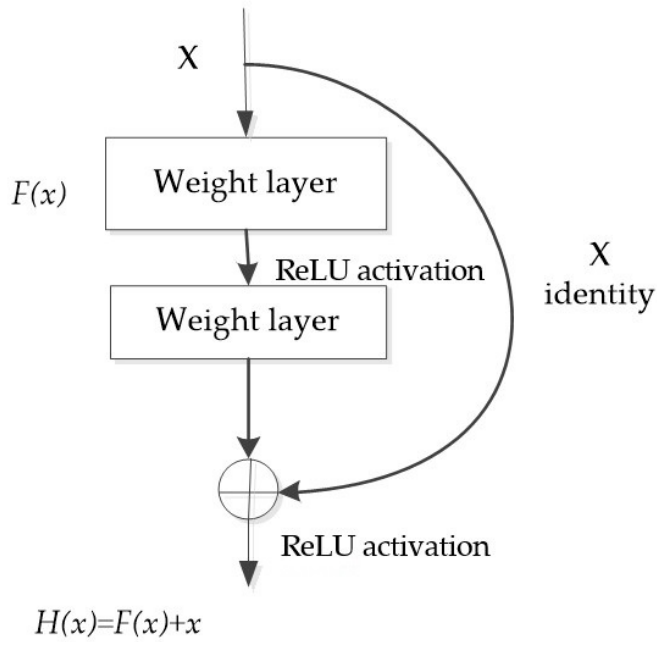
Figure 3. Residual unit structure diagram.